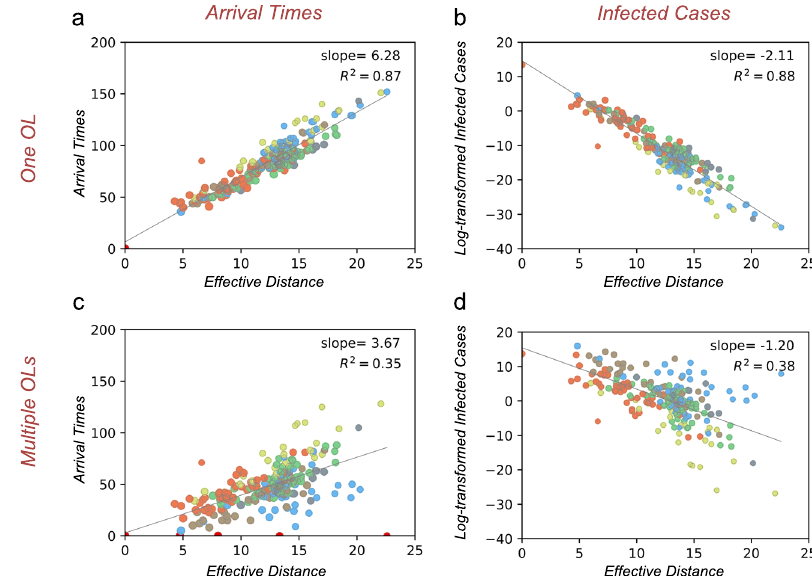
Fig. 1 Global disease dynamics cannot be predicted by effective distance when the outbreak locations (OLs) are evolving. a , b depict the global disease dynamics, i.e., arrival times T m and log-transformed infected cases I m ( t ) (e.g., t = 50) as functions of effective distance from the initial OL, respectively. However, when the single OL evolves to multiple OLs (e.g., fi ve OLs), see c and d , the effective distance from the initial OL fails to correlate with arrival times T m and log-transformed infected cases I m ( t ), with an R -squared value ( R 2 ) < 0.4. Circles represent geographical areas, and those belonging to the same continent are presented in the same color. Both arrival time and infected cases are obtained from the meta-population susceptible – infected – removed model, with epidemiological parameters provided by the literature 55,56 .